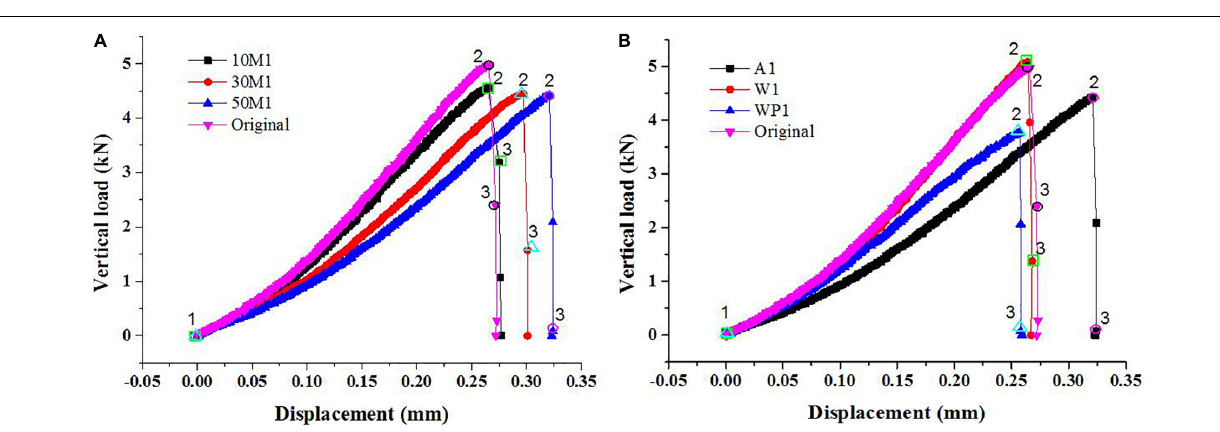
specimens in Cd group with no obvious pattern. The details will be discussed in the following